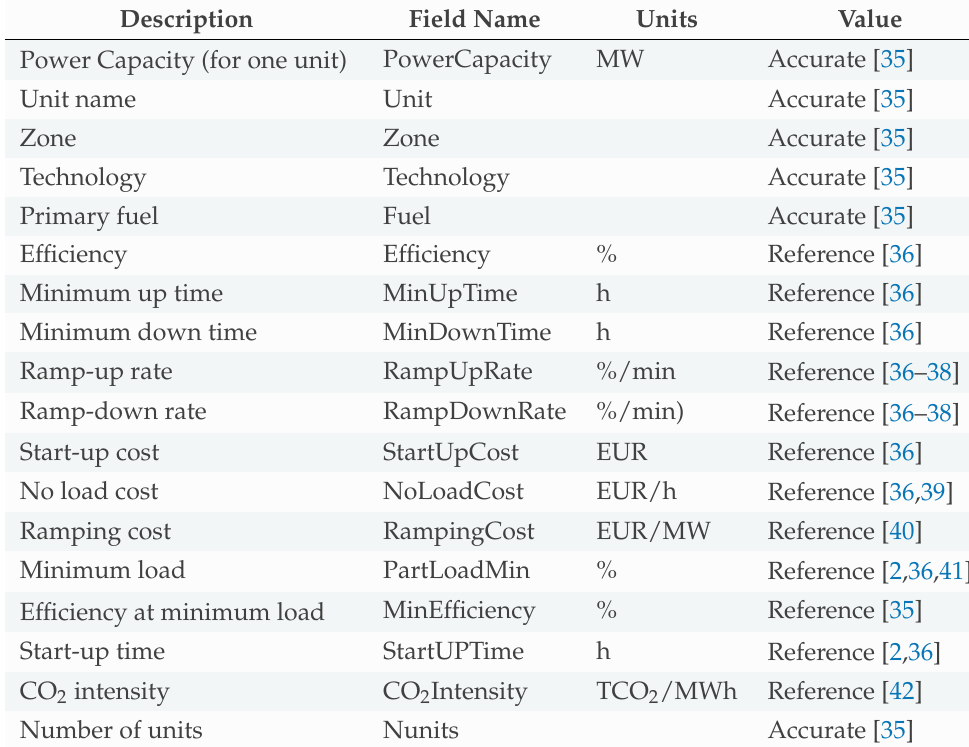
Table 1. Power units parameters